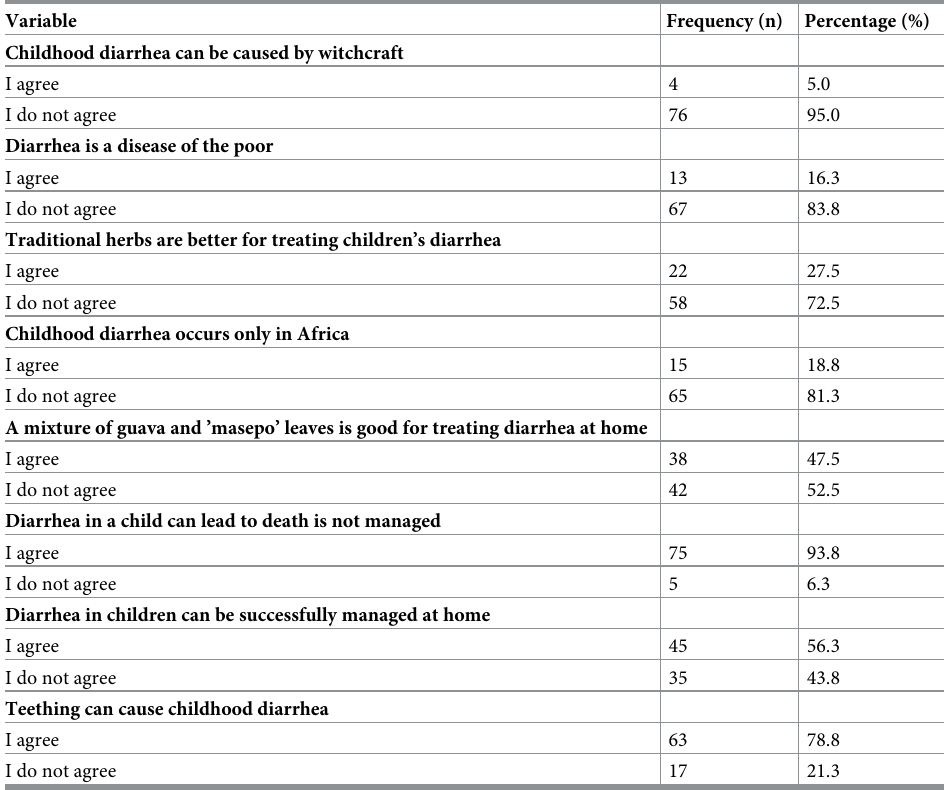
Table 8. Attitude on the management and prevention of childhood